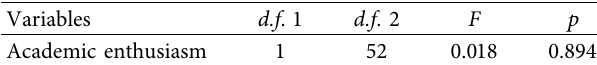
Table 3: Equivalence analysis of variances based on Levene’s test